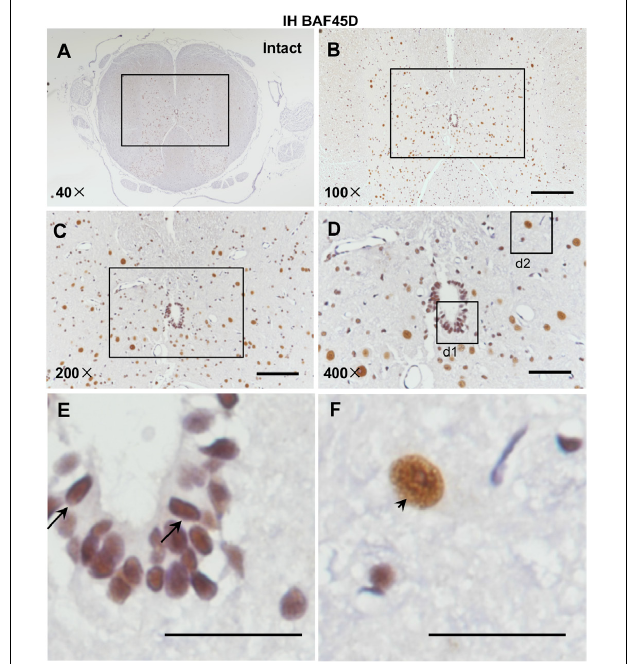
FIGURE 1 | Expression of BAF45D in the SCECs and neurons of intact spinal cords from adult rats. (A–E) Immunohistochemical assays were performed using anti-BAF45D antibodies on histological sections prepared from the intact spinal cords of adult rats. (B) Shows a 100 × magnification of the inset shown in (A) , while (C) shows a 200 × magnification of the inset shown in (B) . (D) Represents a 400 × magnification of the inset shown in (C) while (E,F) represent 2600 × magnification of insets d1 and d2, respectively. Scale bars: 200 µ m (B) , 100 µ m (C) , 50 µ m (D) , and 25 µ m (E,F) .